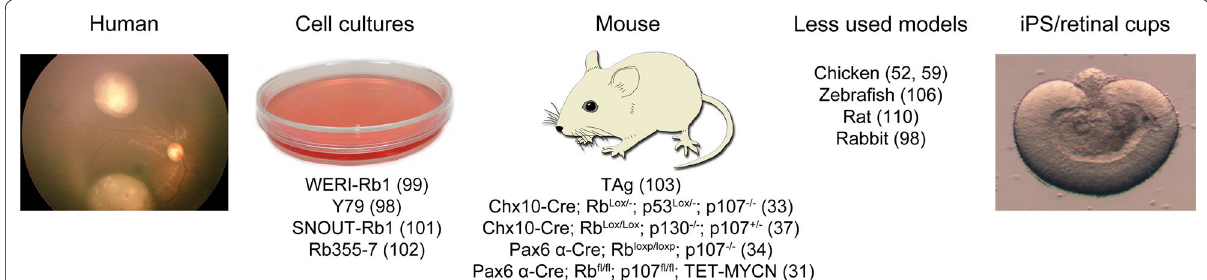
Fig. 5 Research model for retinoblastoma. As human tumors are difficult to analyze other in vitro and in vivo models have been developed. There exist several cell lines that have been established from human tumors. Multiple mouse models have also been developed to recapitulate retino‑ blastoma with a selection presented here. Other, less used models include zebrafish, rat, and rabbit, where primarily transplantation experiments have been performed. Retinal cups from iPS cells have emerged as a promising technique for modeling retinoblastoma that may have a closer resemblance to the initiation and progression of the